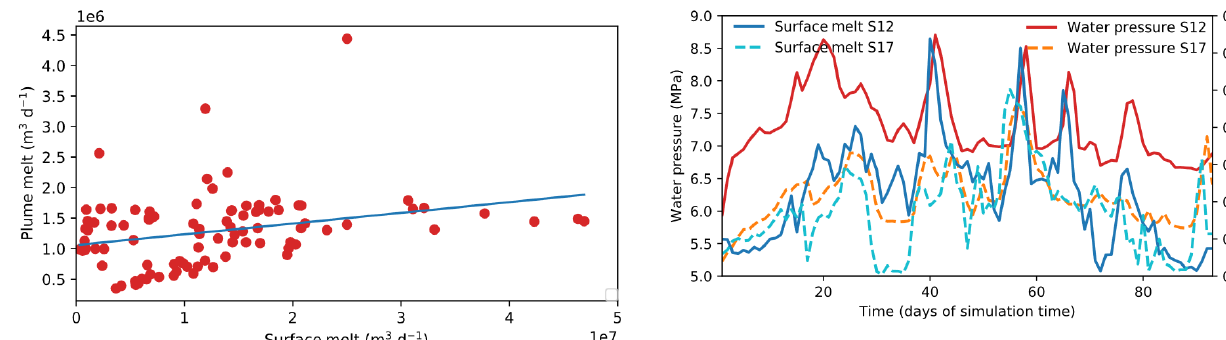
Figure 12. Time series showing comparison between average water pressure (left axis) and surface melt (right axis) for SummerDaily12 (solid lines) and SummerDaily17 (dashed lines) model runs. Note the correlation between surface melt and water